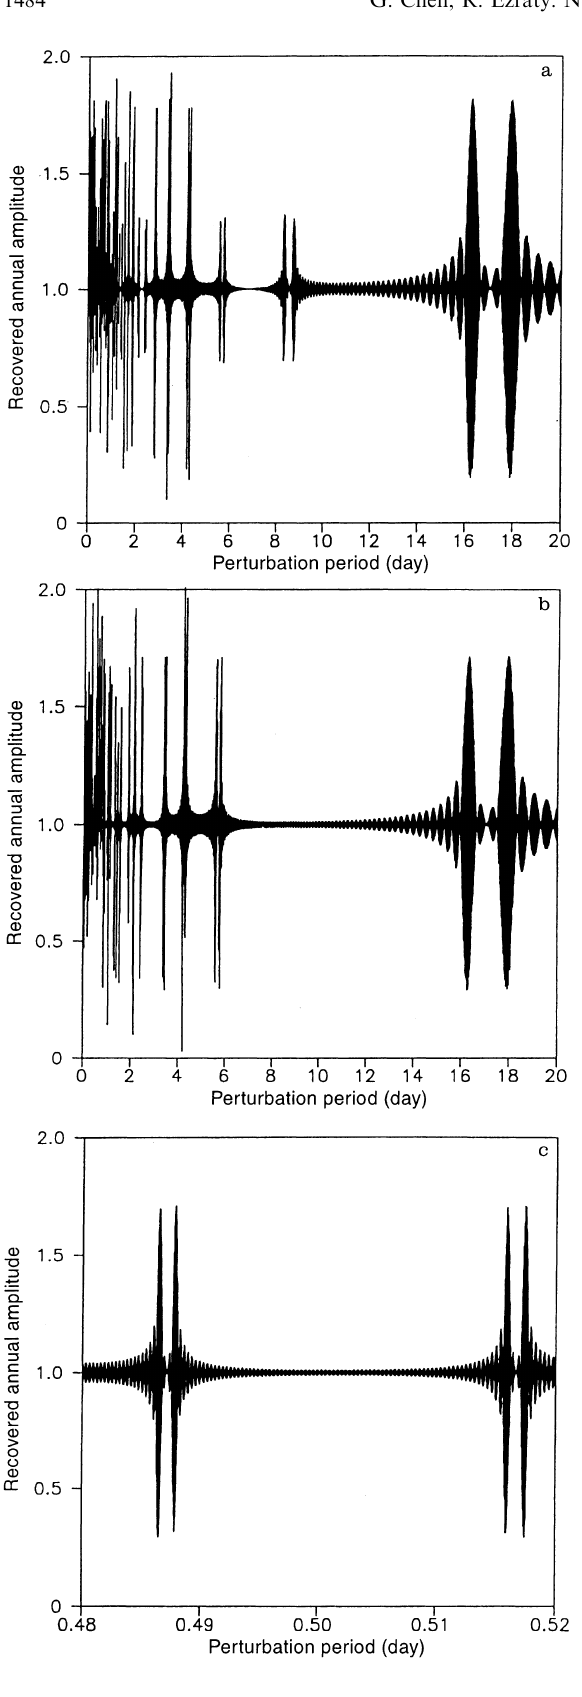
(cid:98) Fig. 6a–c. The recovered amplitude of an annual harmonic signal with respect to the perturbation period. The simulation is performed with data from both ascending and descending tracks at crossover points for a duration of 2 years. The time di(cid:128)erence between two successive ascending and descending samples is a T s = 5 and b T s = 4; c is a zoom of b